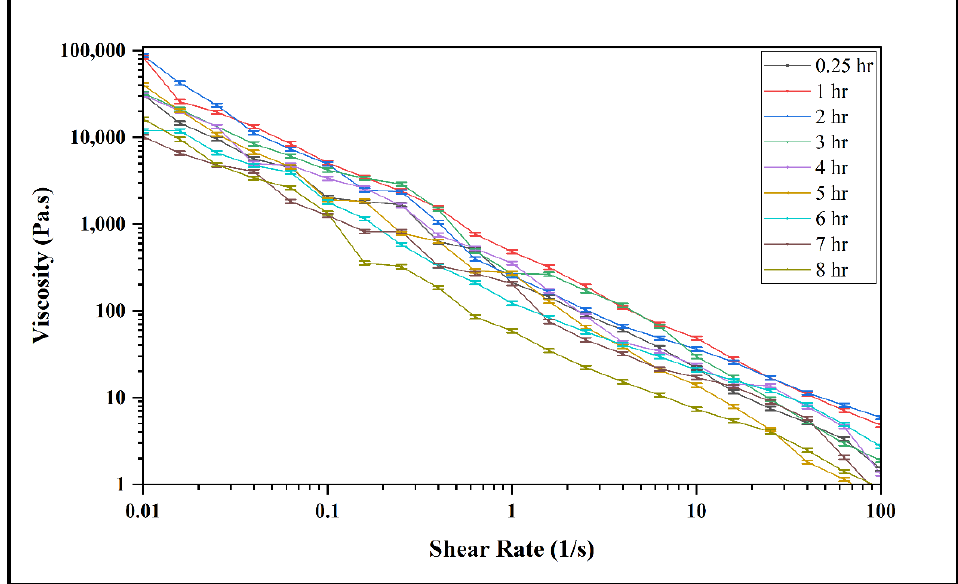
Figure 8. Viscosity vs. shear rate graphs for 9 levels of waiting time.